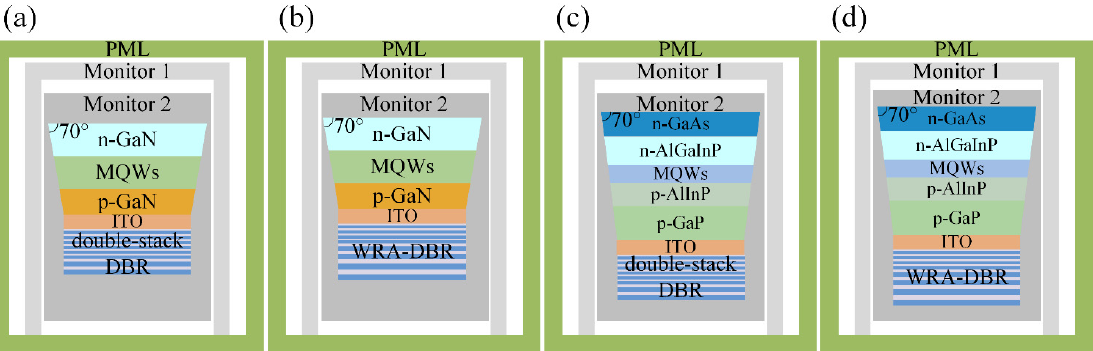
Figure 6. Simulation model of ( a ) blue/green micro-LED with double-stack DBR, ( b ) blue/green micro-LED with WRA-DBR, ( c ) red micro-LED with double-stack DBR, ( d ) red micro-LED with WRA-DBR.